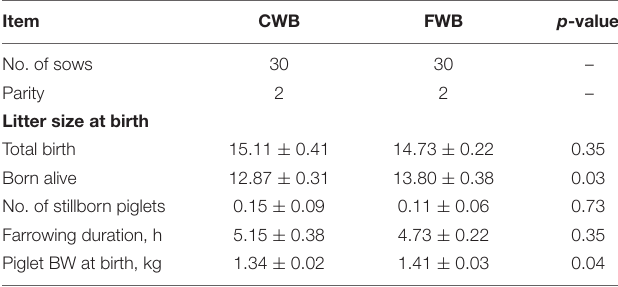
( Figure 4E ). At the genus level, the relative abundances of